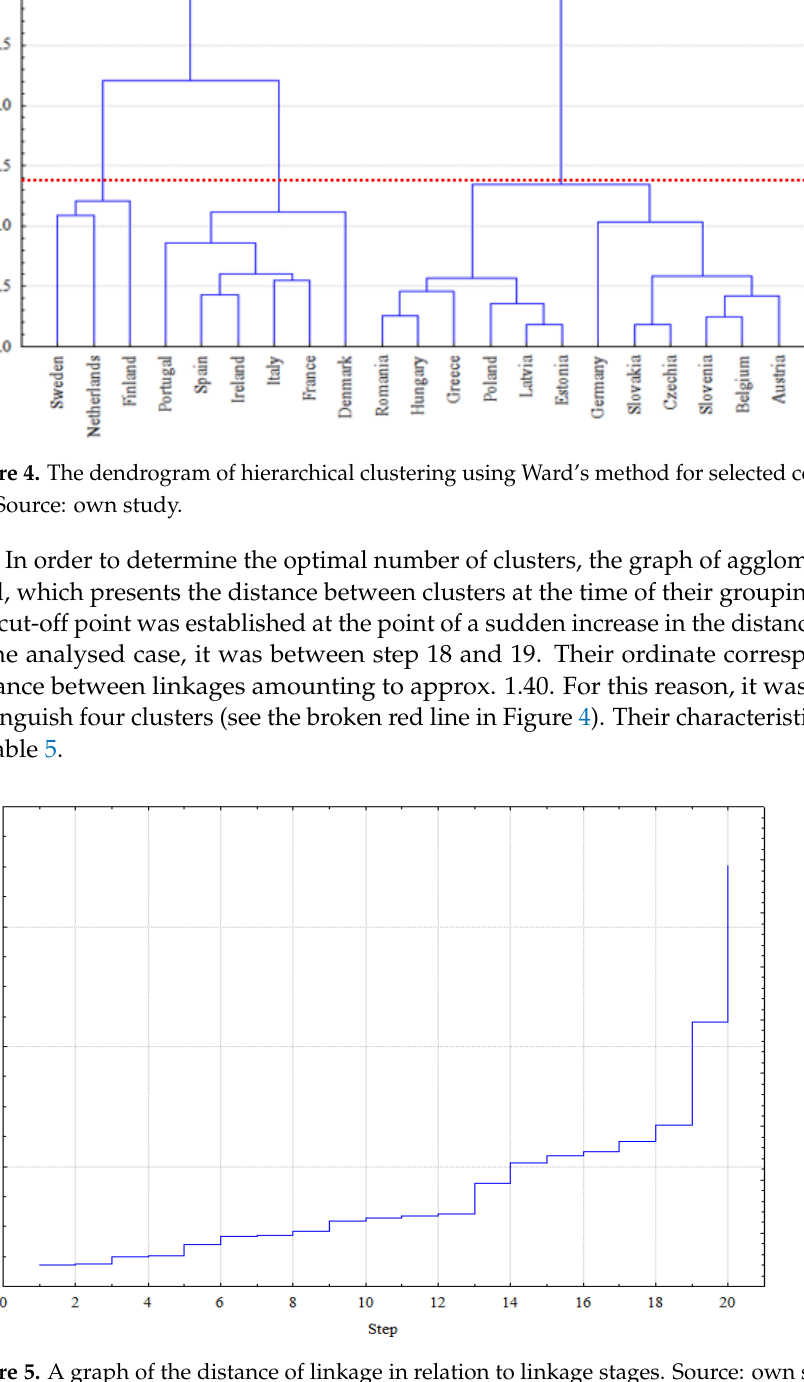
Figure 5. A graph of the distance of linkage in relation to linkage stages. Source: own